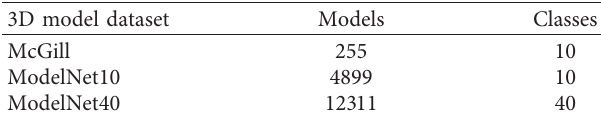
Table 2: 3D model datasets.